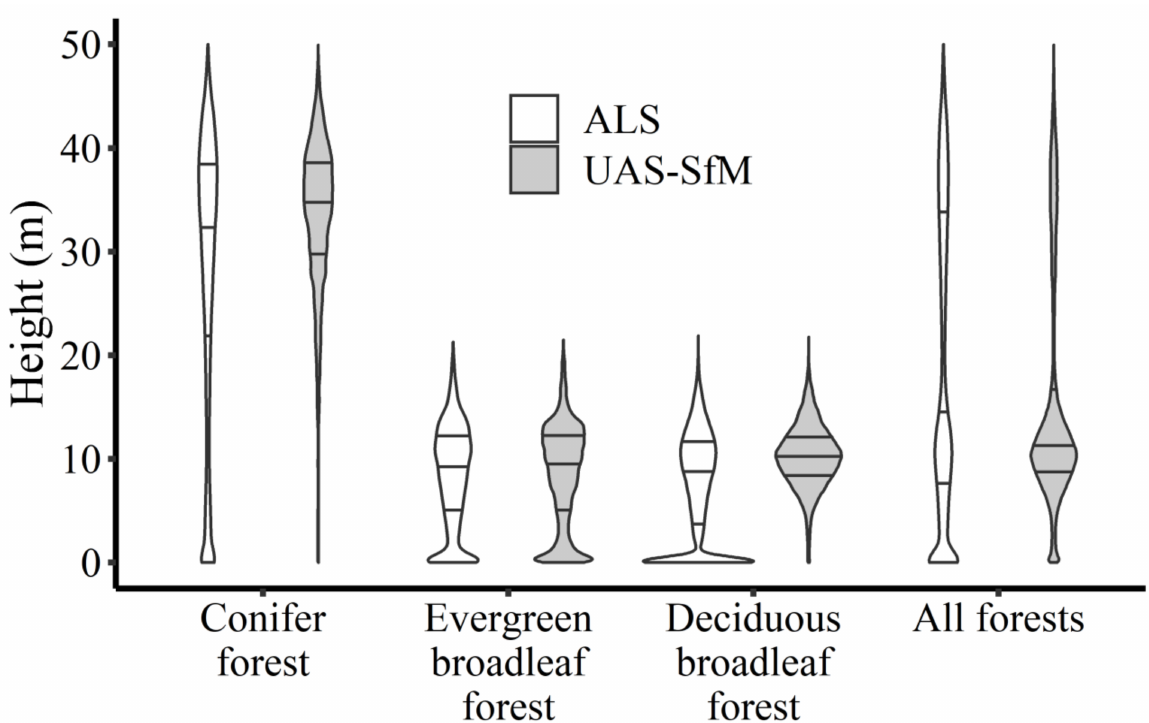
Figure 5. Above-ground point cloud height distributions (meters) from complete study-site data by forest type as measured by ALS (white) and UAS-SfM height normalized using the ALS DTM (shaded). Plots scaled for equal area. Horizontal lines represent 25%, 50% and 75% percentiles,